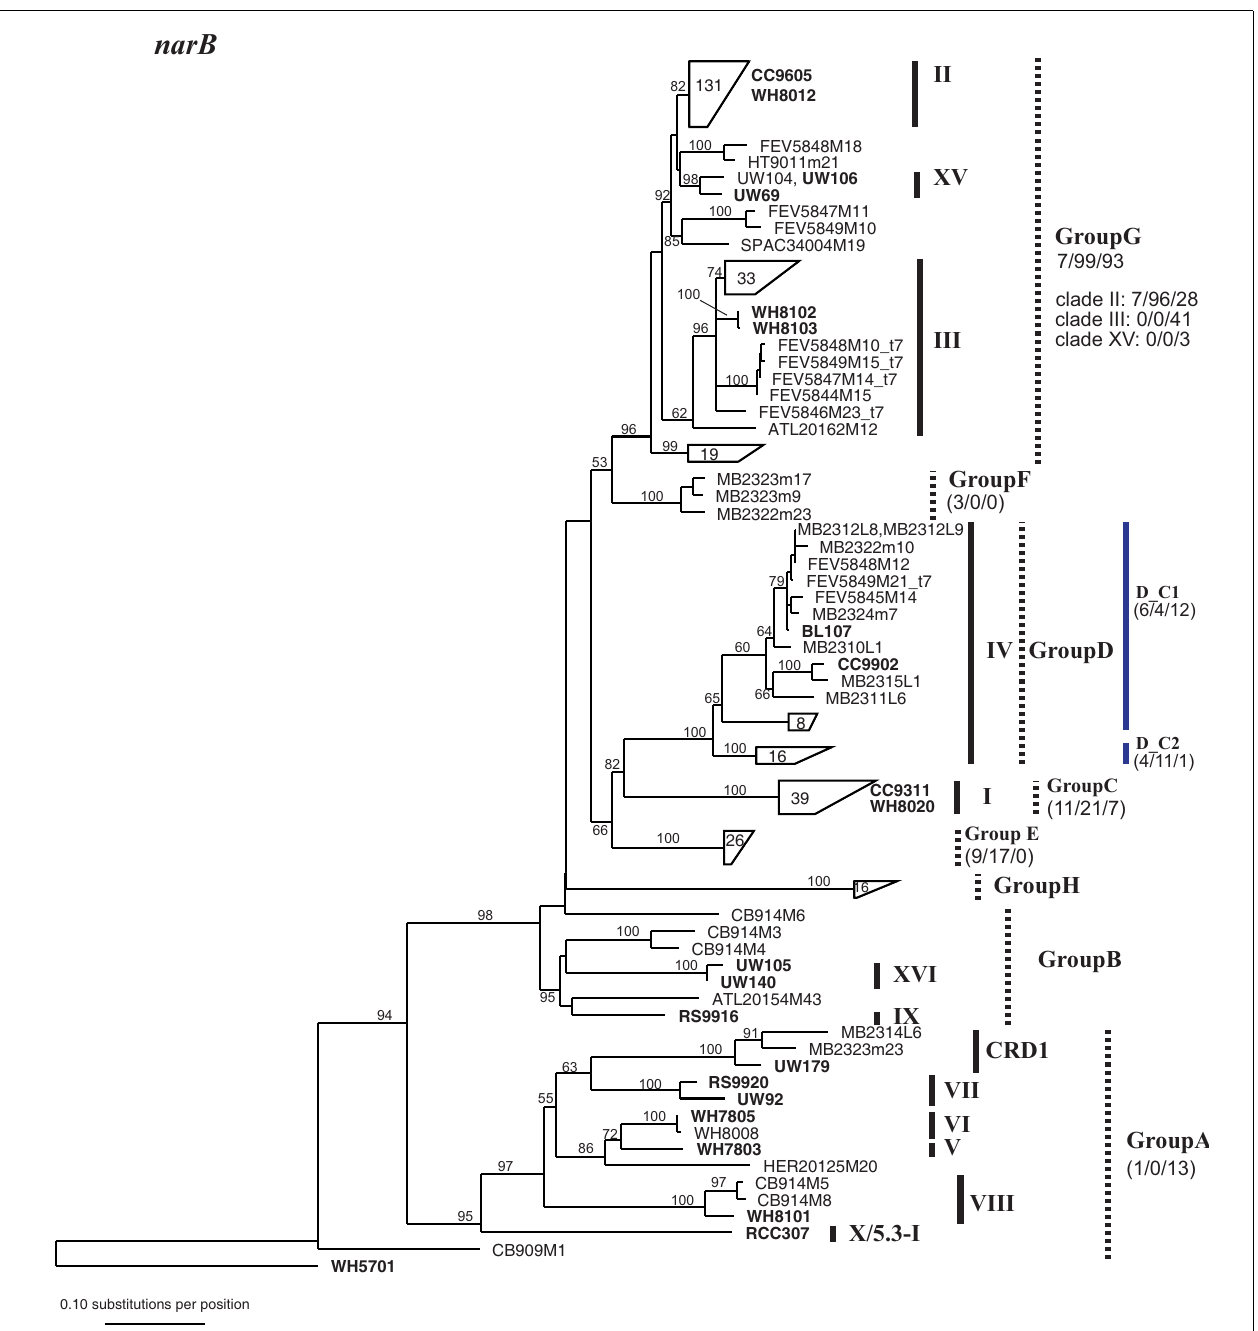
multiple well-established clades as defined by phylogenies of other loci. Numbers below group names indicate the number of total mismatches that sequences within the group have to the primers and probe sets described in Paerl et al. (2011) (0 mismatches/1 or 2 total mismatches/ > 2 mismatches). For Group G which contains multiple clades as defined by other loci, the number of mismatches is also given for sequences belonging to clades II, III, and XV. Two primer and probe sets were designed to detect subgroups of Group D, D_C1, and D_C2 (designated with blue lines), and the number of mismatches that sequences have to their respective primer probe sets are